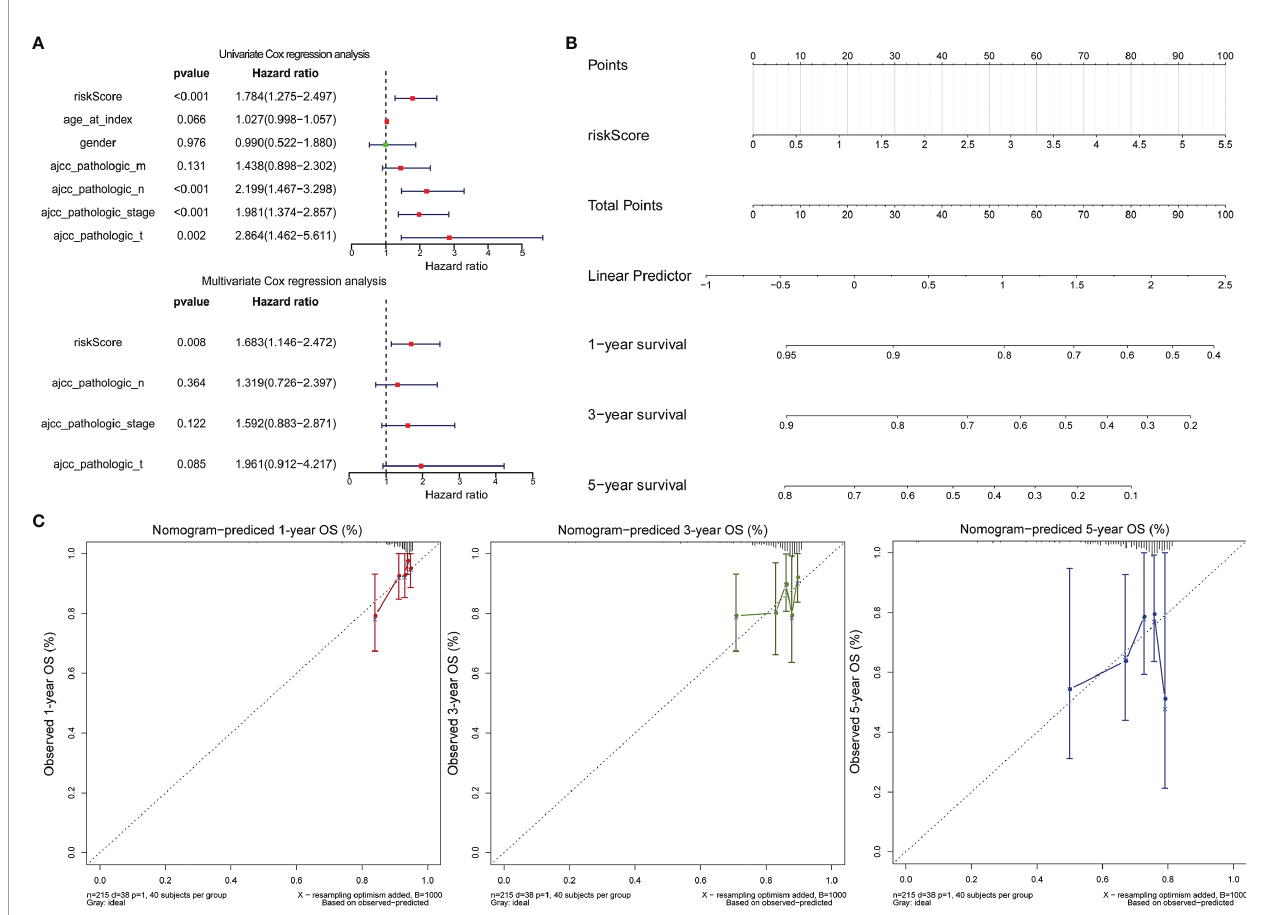
FIGURE 6 | Assessment of the prognostic risk model of the 2 DE-FRGs in LCRC. (A) The univariate (top) and multivariate (bottom) Cox regression analysis of risk score and clinical features regarding prognostic value. Clinical features: age, gender, ajcc pathologic t (tumor size), ajcc pathologic n (lymph node metastasis), ajcc pathologic m (distant metastasis), and ajcc pathologic stage. (B) Nomogram predicting OS for LCRC and RCRC patients. For each patient, one line is drawn upward to determine the points received from the three predictors in the nomogram. The sum of the point is located on the ‘ Total Points ’ axis. Then a line is drawn downward to determine the possibility of 1-, 3-, and 5-year overall survival of LCRC. (C) The calibration plot for internal validation of the nomogram. The Y-axis represents actual survival, and the X-axis represents nomogram-predicted